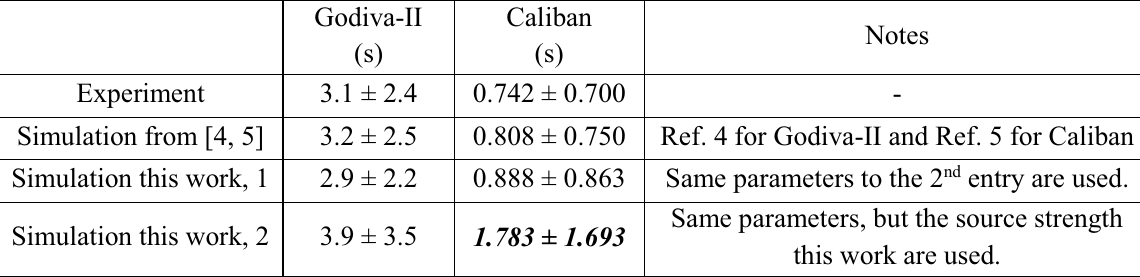
Table III. Results of Burst Waiting Time for Godiva-II and Caliban